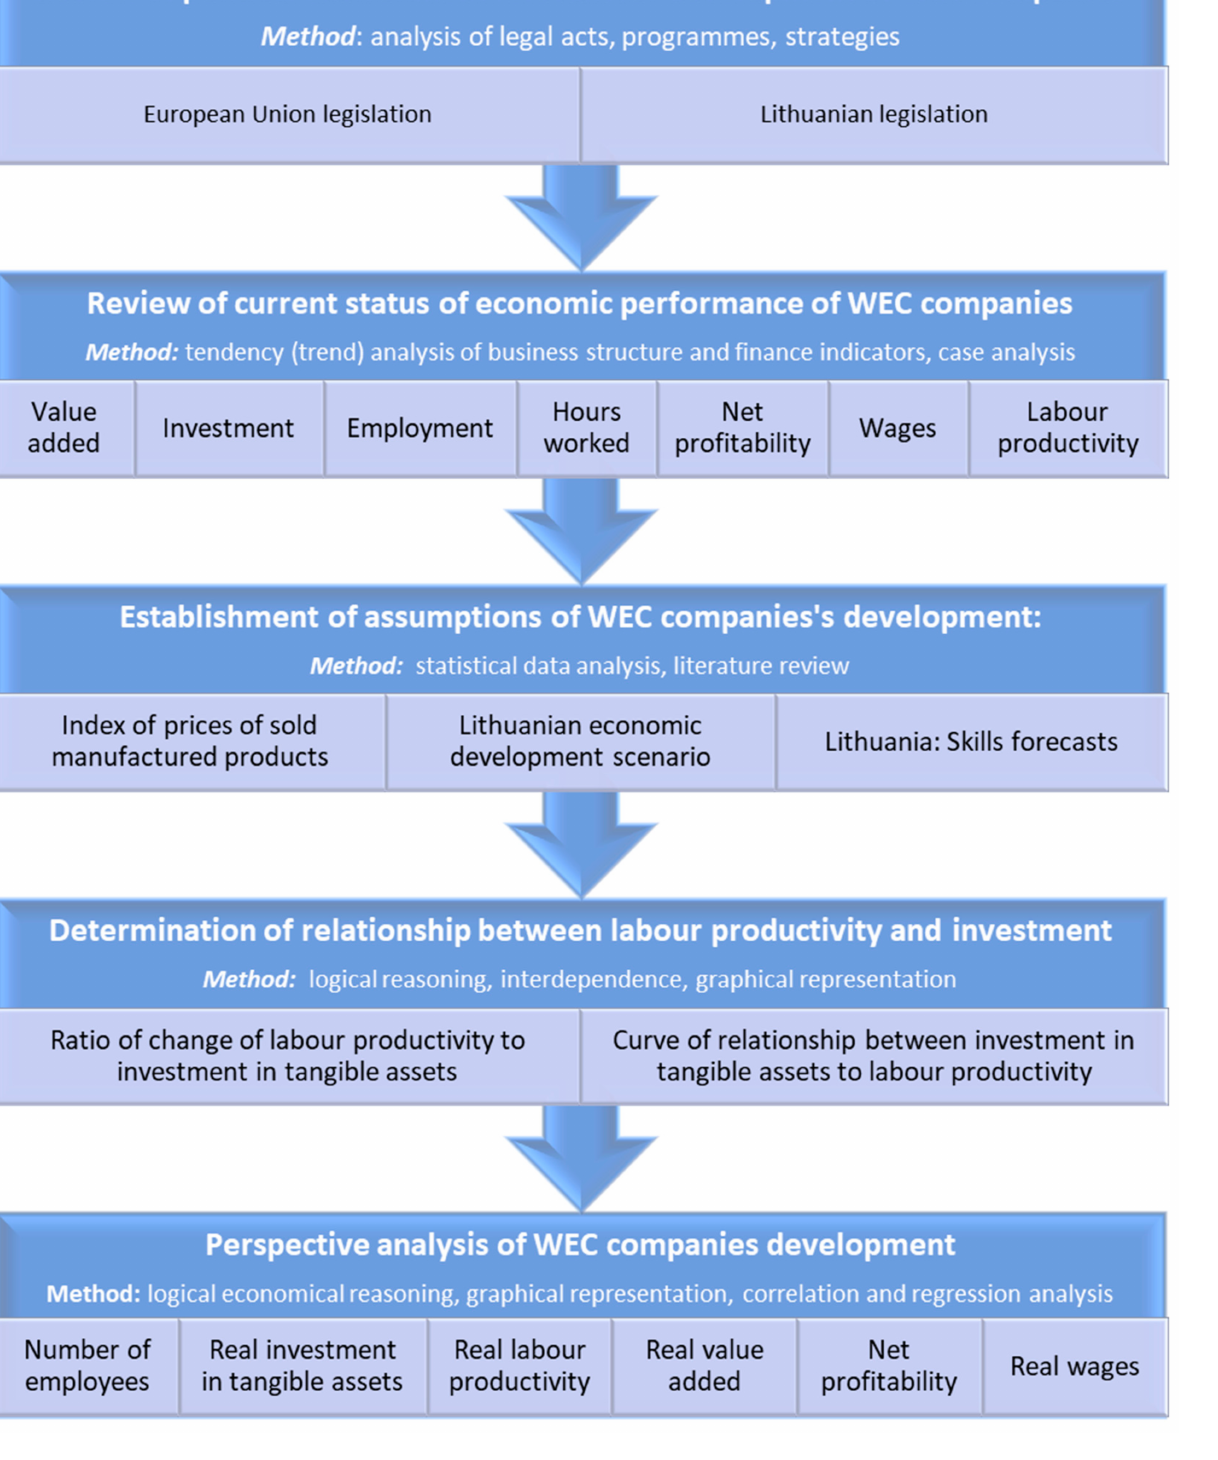
Figure 2. Logical scheme of research performance (own